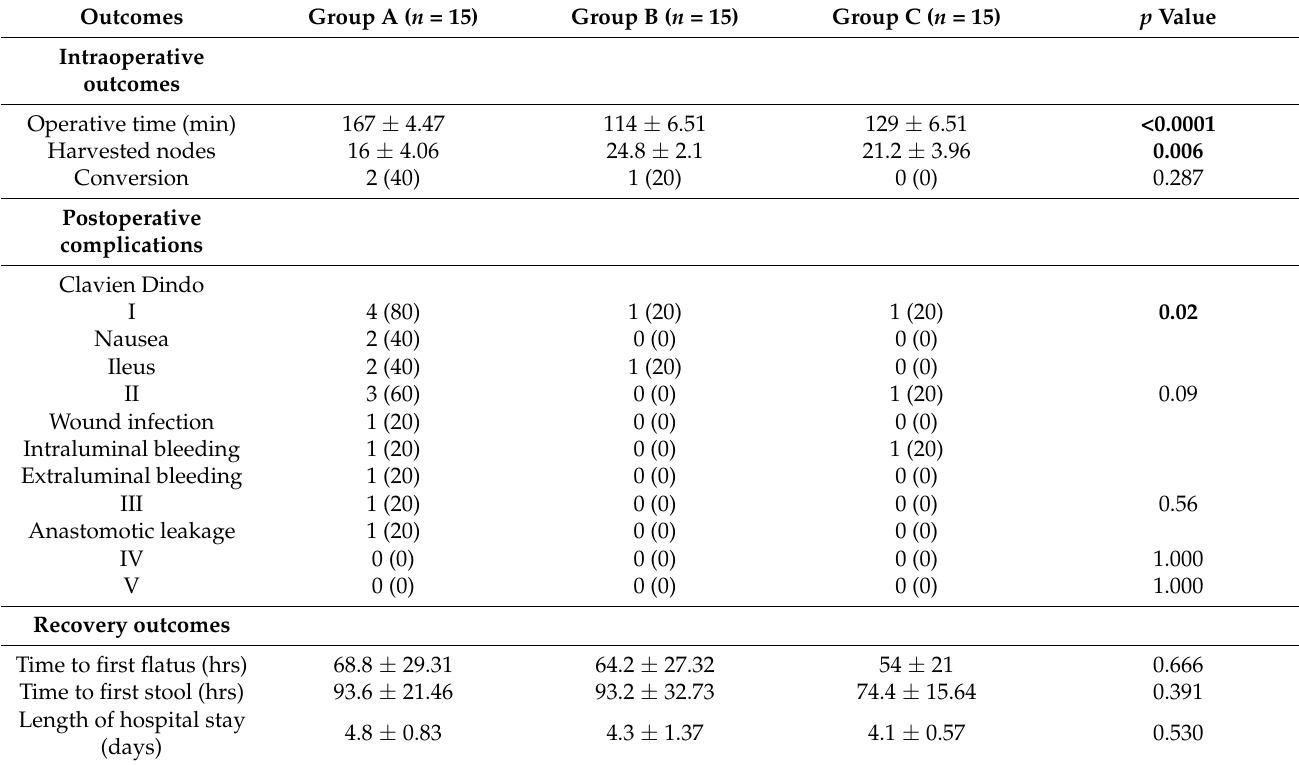
Table 3. Intraoperative outcomes, postoperative complications and recovery outcomes on right